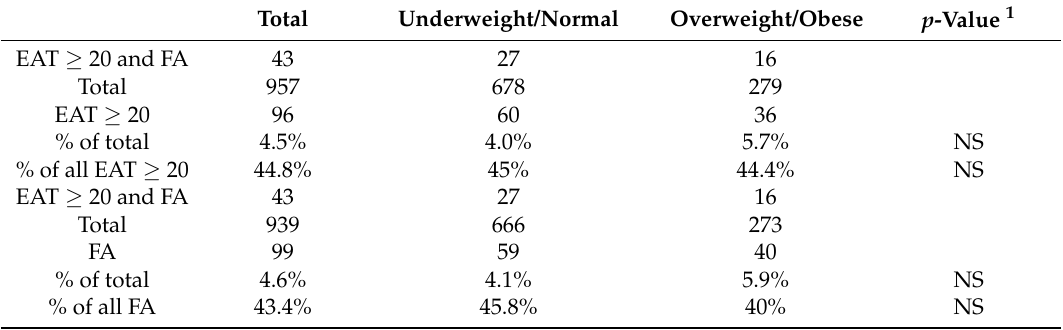
Table 5. Co-occurrence of EAT Score ≥ 20 and food addiction (FA) diagnosis by weight status.